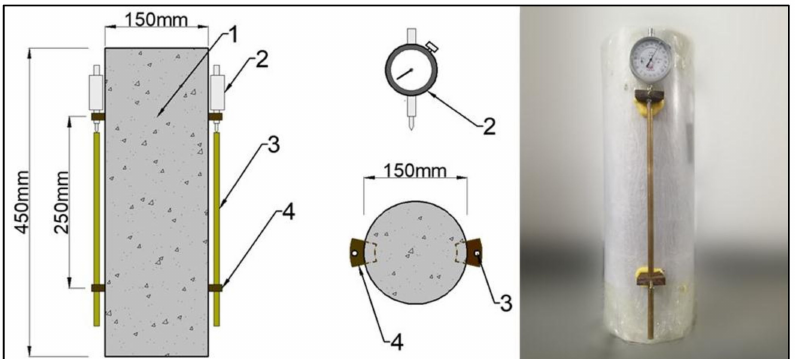
Figure 3. Sketch of specimens and measuring device for autogenous shrinkage deformation. 1—Cylinder specimen; 2—Dial indicator; 3—Gauge copper rod; 4—Embedded